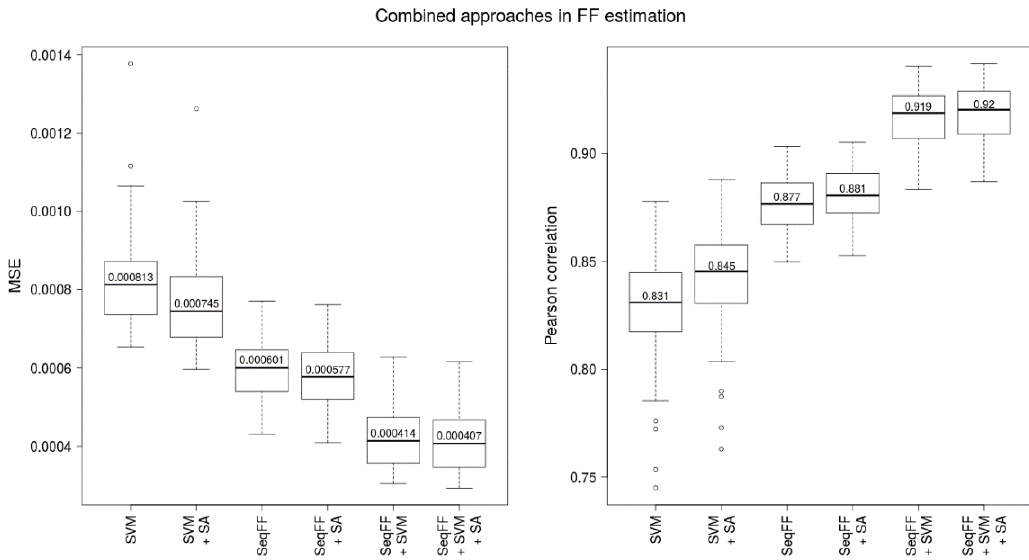
Figure 3. Boxplots of MSE and Pearson correlation of Y-based FF and estimated FF using SVM method calculated for 100 testing sets. Training was performed on 100 complementary training sets. Combined approach is denoted SeqFF + SVM. Improvement for every method was achieved by adding sample attributes (DNA library concentration, BMI, gestational age)—represented by “+ SA”.